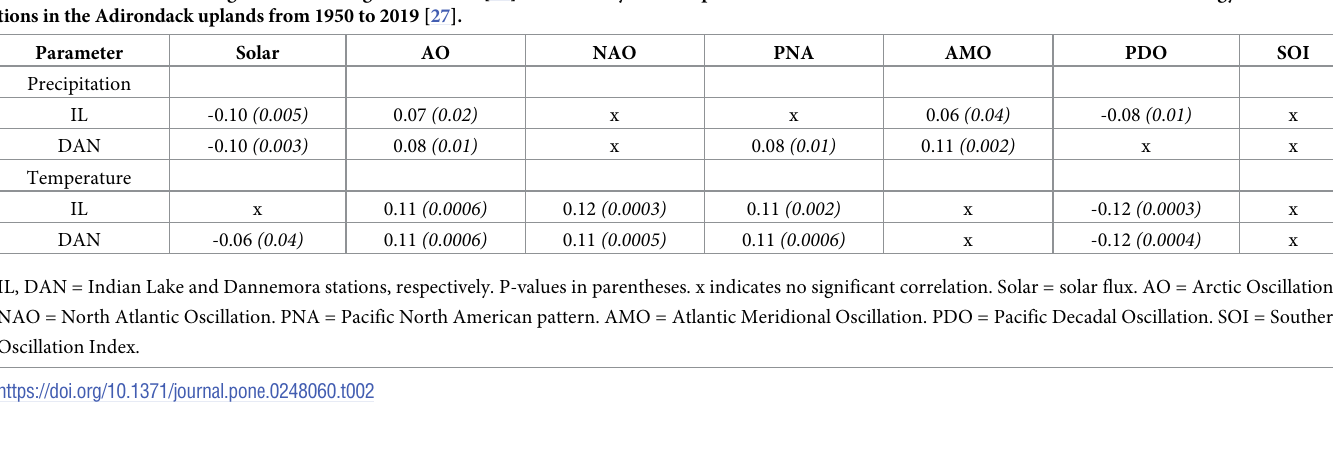
Table 2. Correlations among external forcing mechanisms [56] and monthly weather parameters recorded at two United States Historical Climatology Network sta- tions in the Adirondack uplands from 1950 to 2019 [27]. Parameter